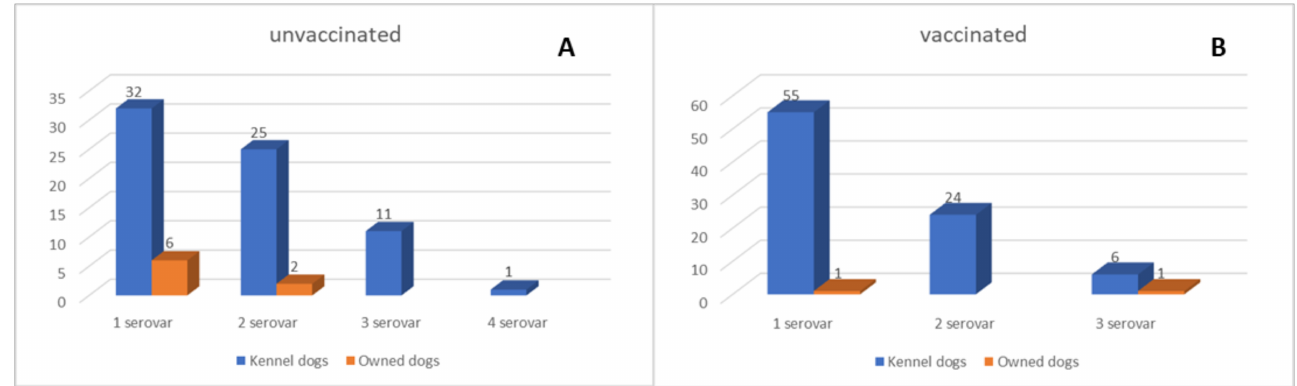
Figure 2. Graphic representations of the single and multiple seropositivity for one or more Leptospira serovars detected in vaccinated ( A ) and unvaccinated dogs ( B